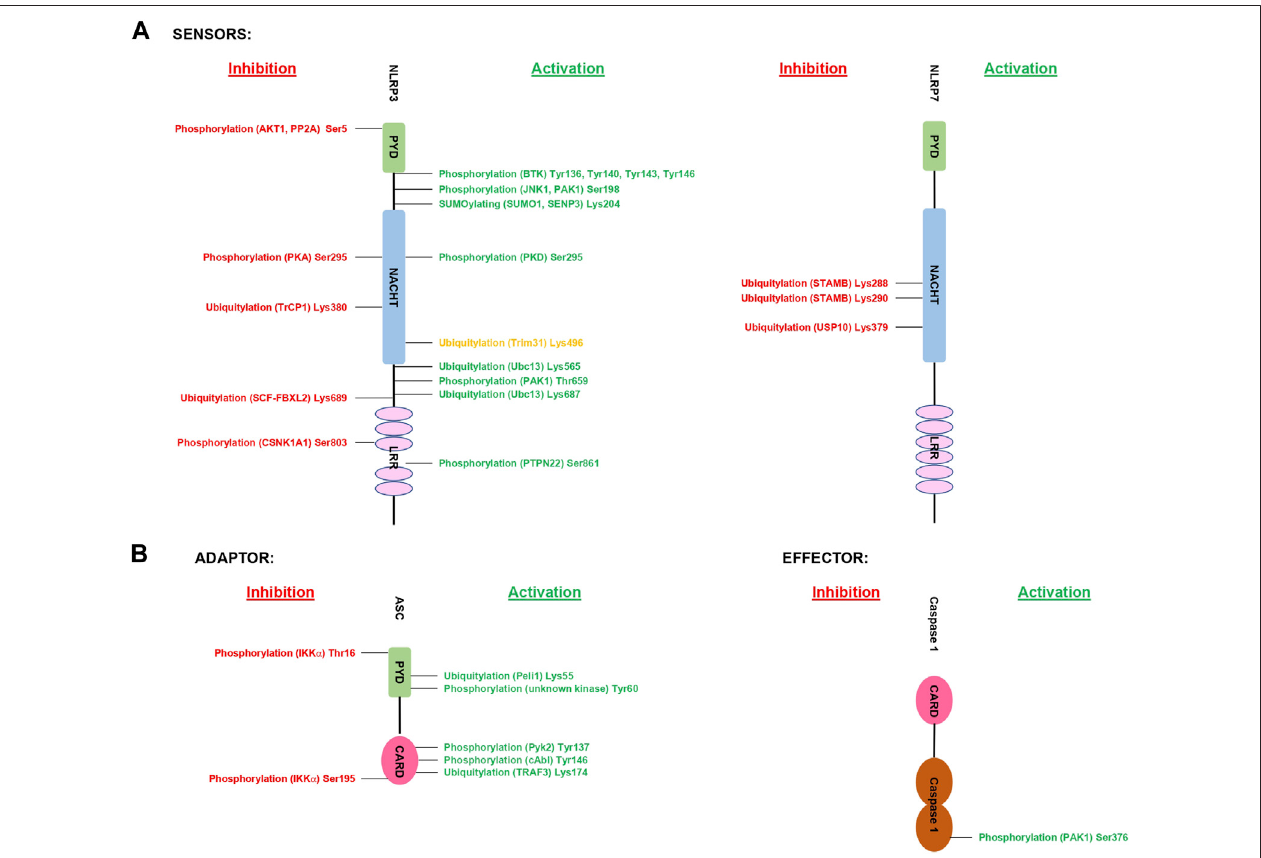
FIGURE 2 | Summary of validated PTMs of in fl ammasome components. The fi gure shows the validated PTMs of in fl ammasome components and the responsible proteins of each modi fi cation. Highlighted in green are validated PTMs with an increased in fl ammasome activity, while PTMs in red indicate validated sites. The site in orange requires further validation of its downstream functional effect. 2 A shows the sensors and 2B the downstream molecules.